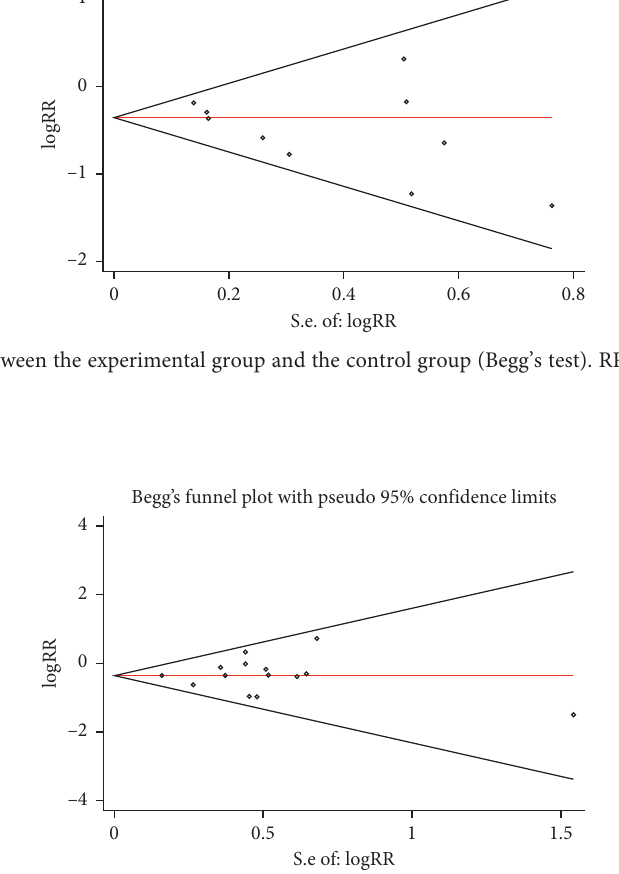
Figure 7: Comparison of MACE between the experimental group and the control group (Begg’s test). RR � risk ratio; MACE � major adverse cardiovascular events.